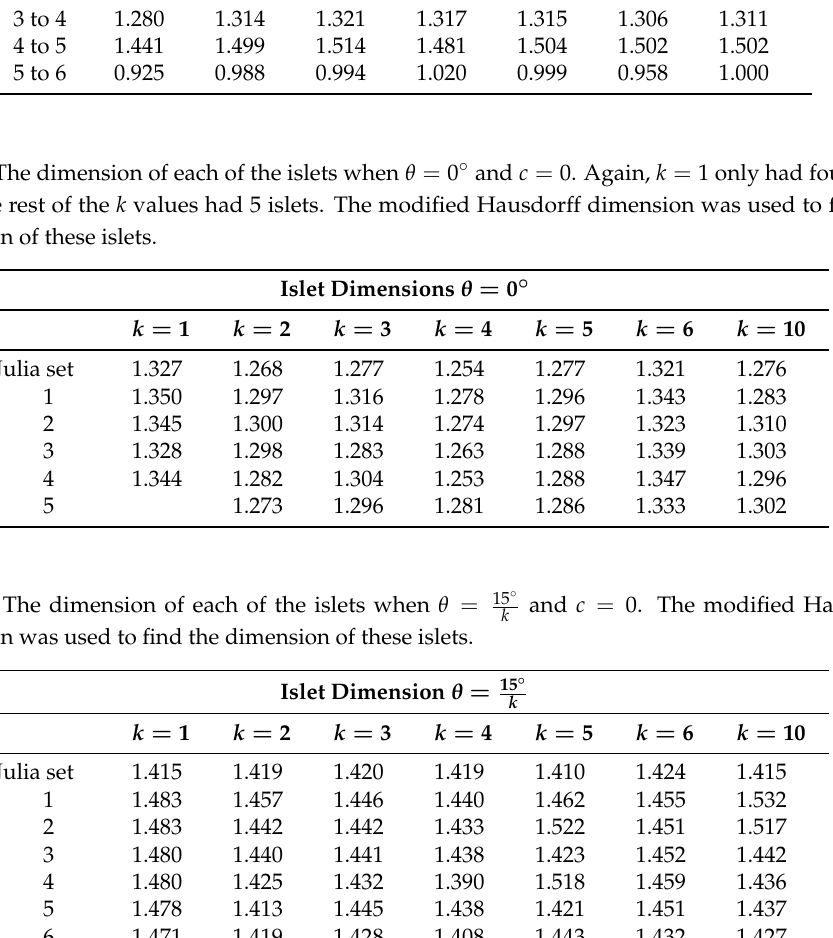
Table 3. The dimension of each of the islets when θ = 0 ◦ and c = 0. Again, k = 1 only had four islets